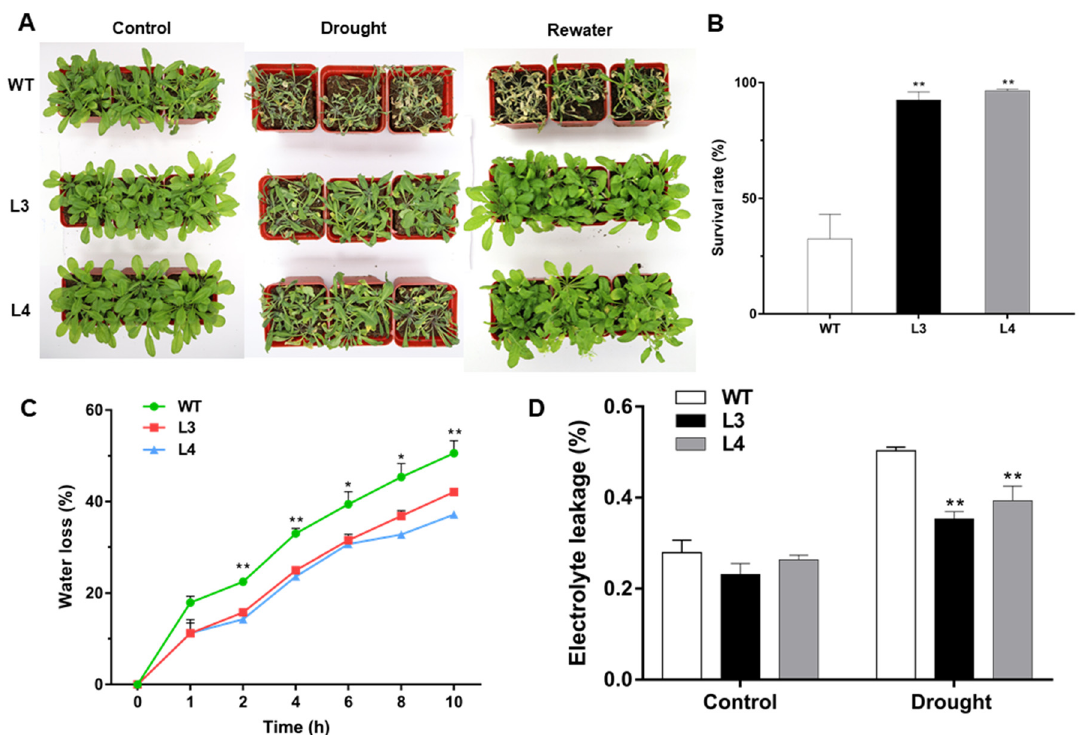
Figure 6. Overexpression of EjWRKY17 confers tolerance to drought stress in Arabidopsis . ( A ) Phenotype of Arabidopsis with overexpression of EjWRKY17 under water deficit. ( B ) Survival rates of seedlings. ( C ) The water loss of detached leaves. ( D ) Electrolyte leakage. Plants were photographed on 2 d (control) and 15 d (drought) without irrigation and on 3 d after rewatering (rewater). Error bars represent ± SD ( n = 3). Asterisks denote significant differences (as compared with the control group): * p < 0.05; ** p < 0.01.